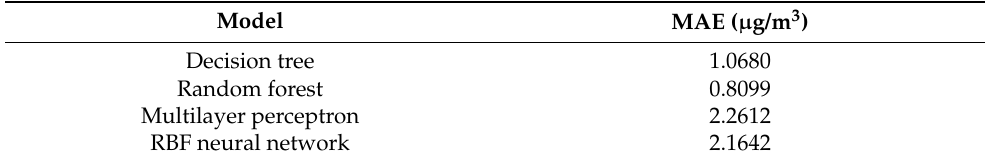
Figure 16. Comparison of the model output results: output results of the ( a ) decision tree model, ( b ) random forest model, ( c ) multilayer perceptron model, and ( d ) RBF neural network model. Table 3. MAE values of the learning models.